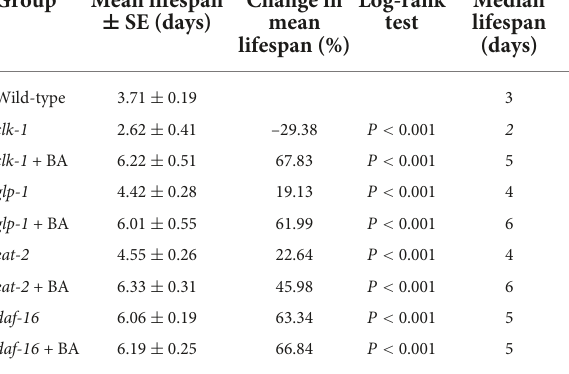
TABLE 5 DAF-16 is required for betulinic acid (BA)-induced oxidative stress resistance. Group Mean lifespan ± SE